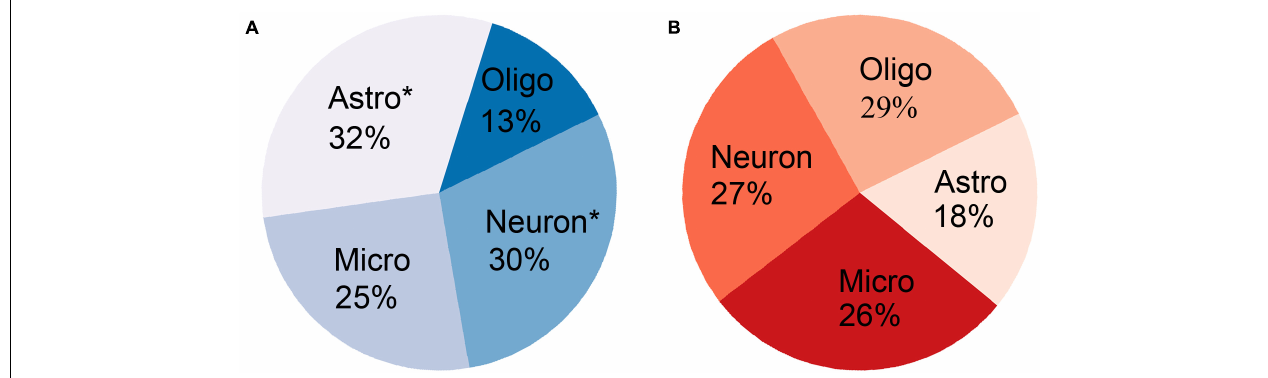
FIGURE 5 | The percentage of gene ratio between overlapping genes and cell-type-specific genes for each type of neocortical cell. (A) The PLS1- genes significantly overlapped with cell-type-specific genes in neurons and astrocytes (asterisk) but not in oligodendrocytes and microglia. (B) The PLS1 + genes did not significantly overlap with cell-type-specific genes in any type of neocortical cell.